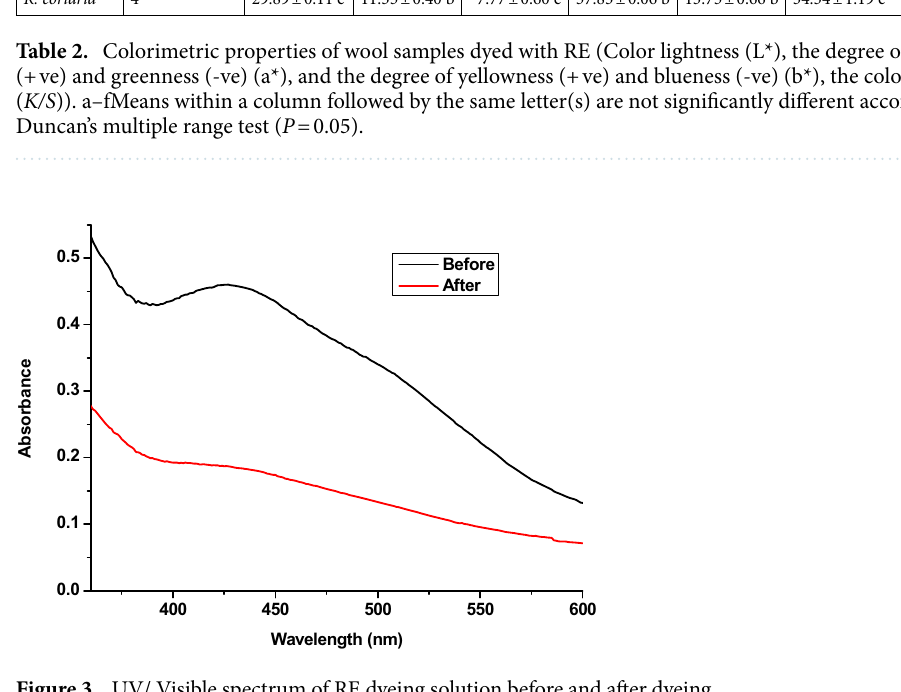
Figure 3. UV/ Visible spectrum of RE dyeing solution before and after dyeing.